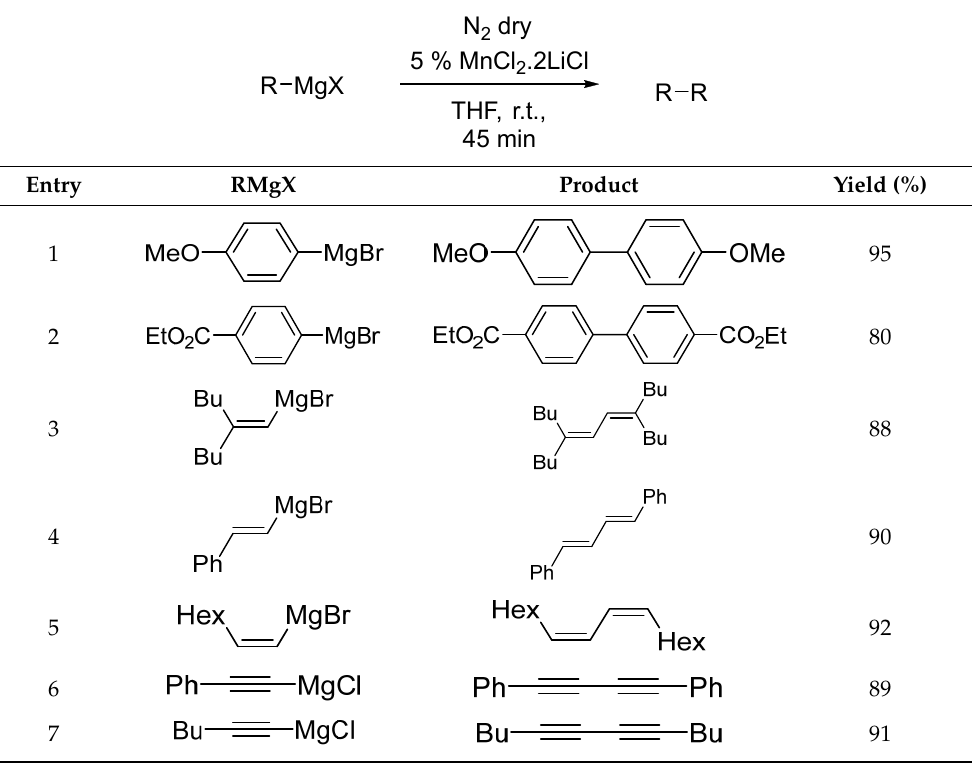
Table 2. Homocoupling of organomagnesium compounds in the presence of MnCl 2 .